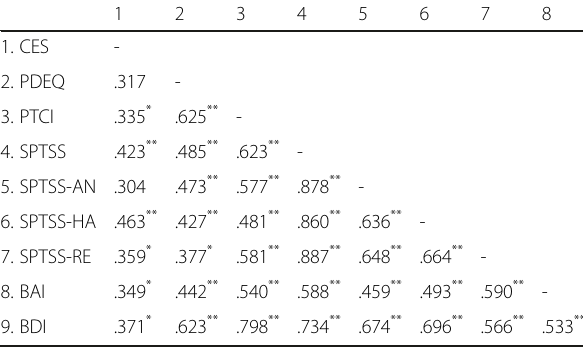
Table 2 Spearman correlations in the PTSD group